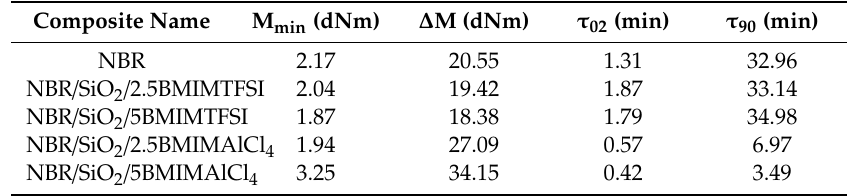
Table 1. Rheometric parameters of silica-filled NBR composites with di ff erent ionic liquids.